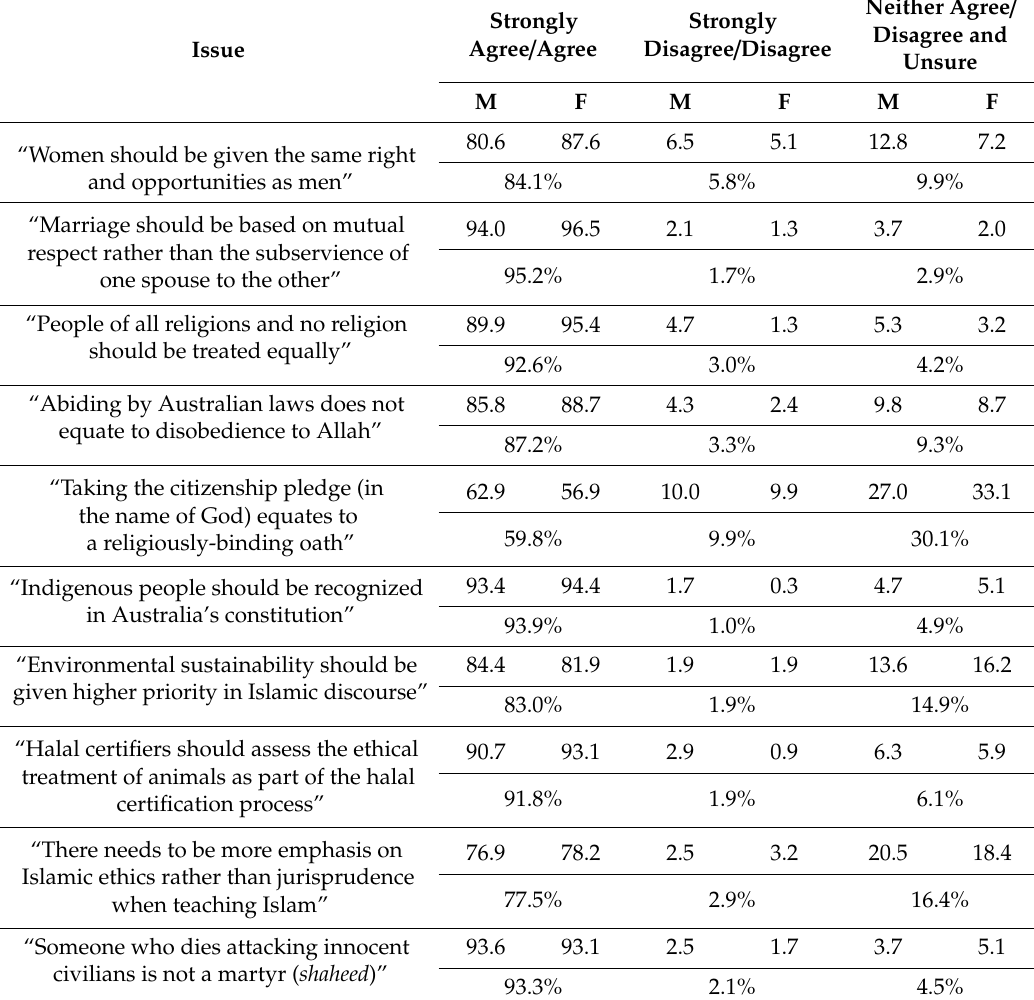
Table 4. Ethical, social, and theological issues by